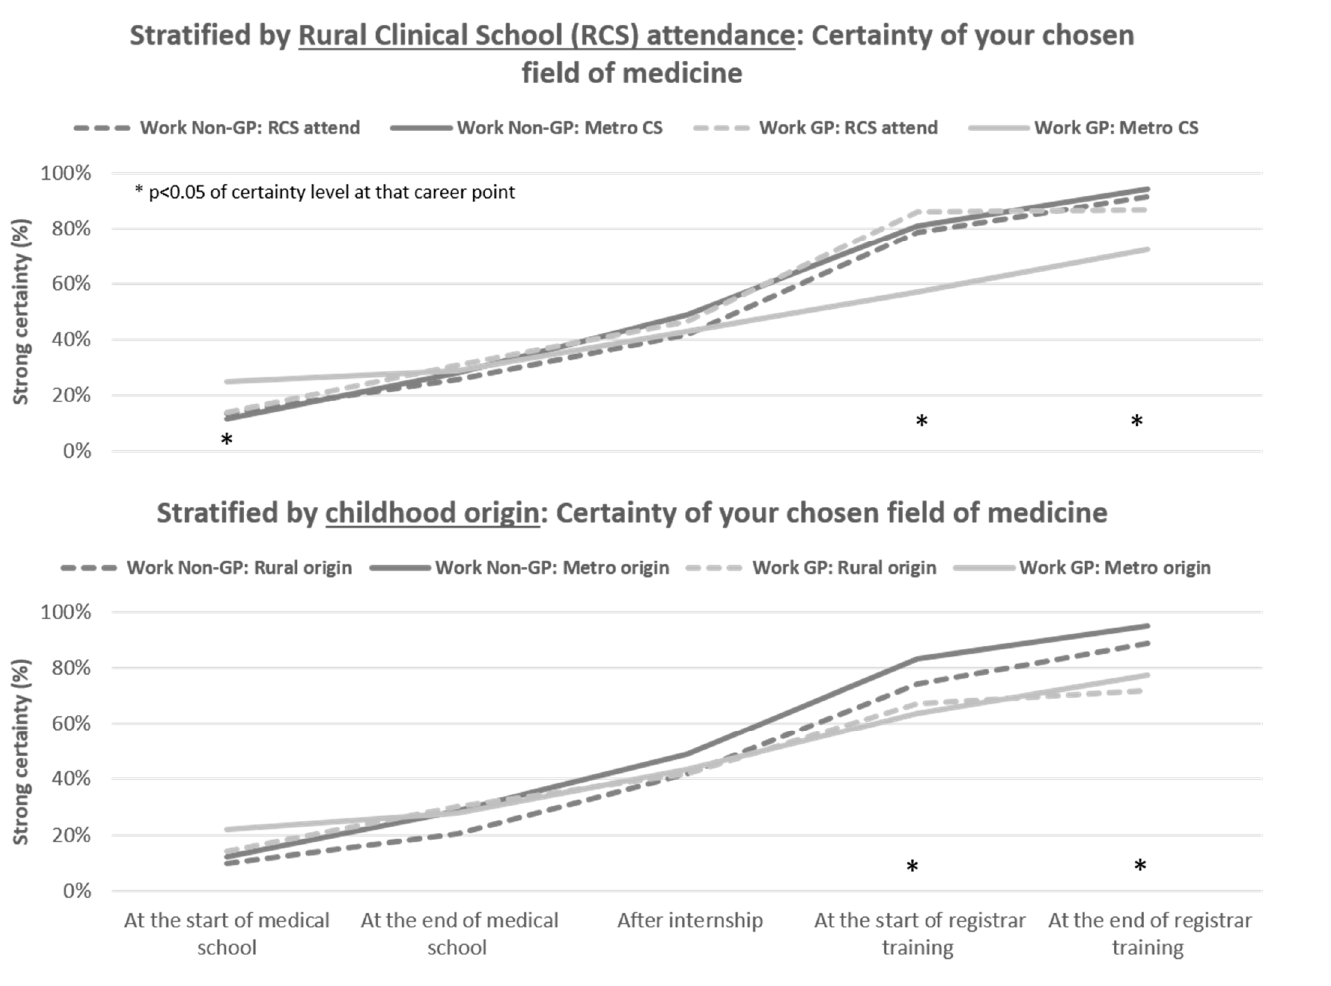
Figure 2. Level of certainty of their specialty decision amongst junior doctors, by key rural strata (childhood origin, clinical school training location).